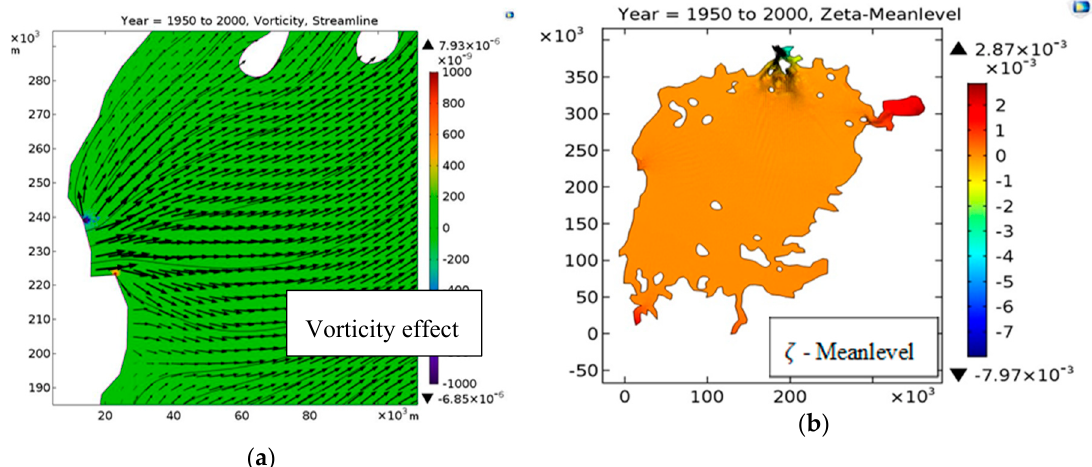
Figure 10. Flow patterns in 2000: ( a ) Non-vanishing vorticity at edges of the Kagera inflow model; and ( b ) wave height measured from the mean level.